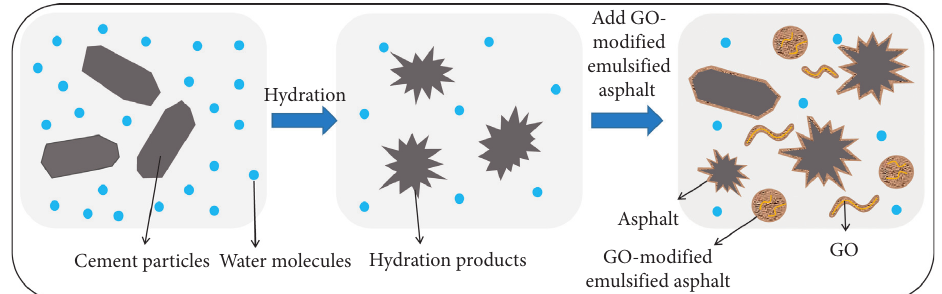
Figure 13: Diagrammatic sketch of GO influence on